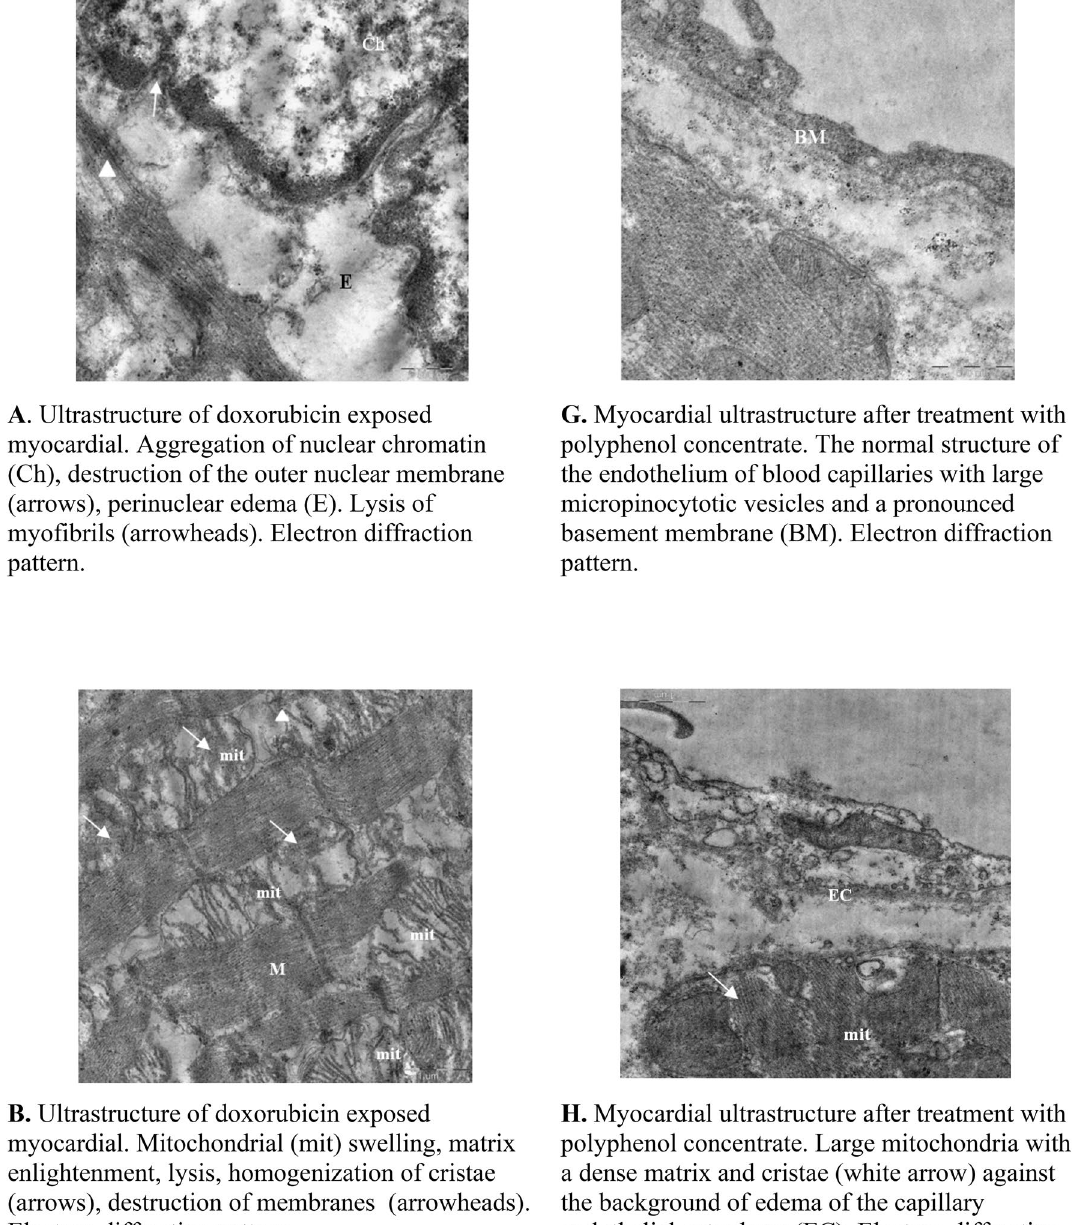
Figure 3. Electron Microscopy analyses. The above images are of rat myocardial tissues from doxorubicin treated animals ( A – F ) and grape polyphenol concentrate treated animals ( G – L ). Tissues from all the animals (6 per group) were analyzed and the images presented are from at least 3 different animals. Images were captured using MegaView G3 TEM-camera and RADIUS EM-Imaging Software. EMSIS GmbH, Muenster, Germany (www.emsis